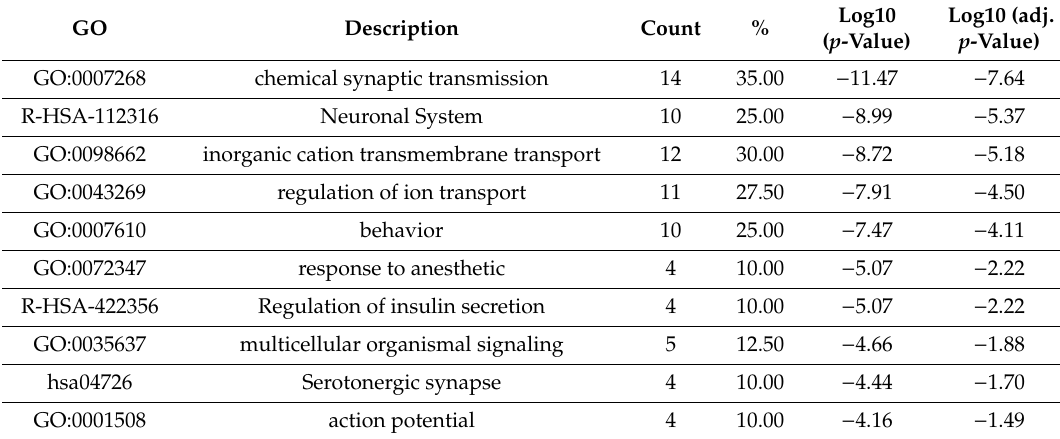
Table 2. Top 10 enriched terms among the neuron-specific